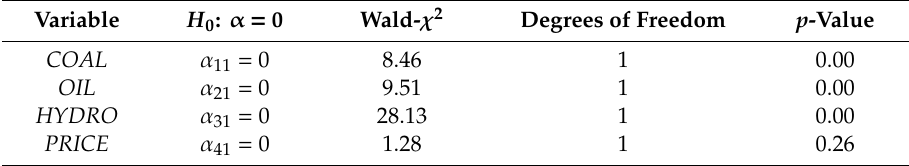
Table 7. Weak exogeneity